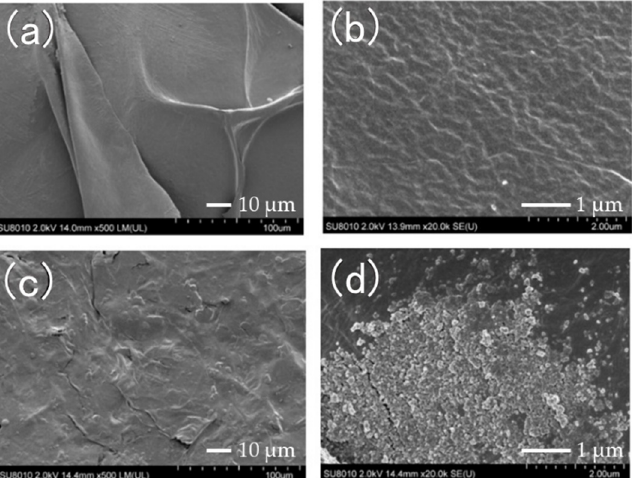
Figure 2. Scanning Electron Microscop y ( SEM) photographs of sponges (( a ): collagen (COL) and ( b ):